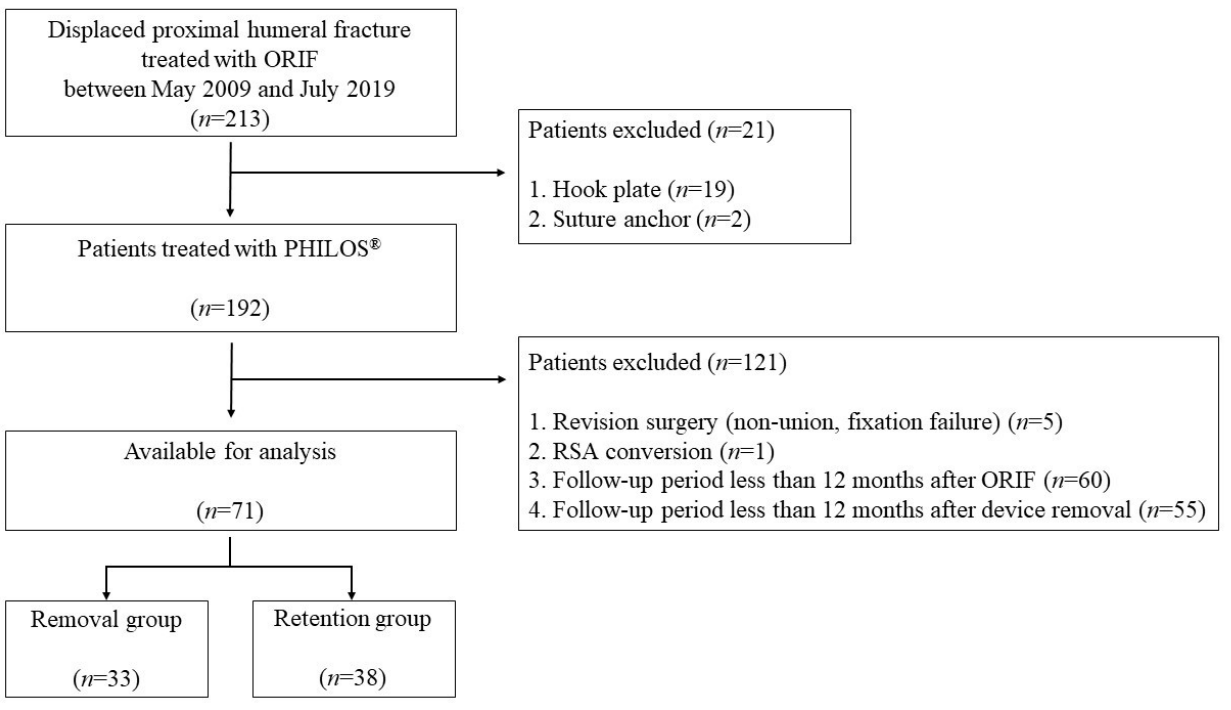
Figure 1. Flowchart of patient inclusion. ORIF: Open Reduction and Internal Fixation.